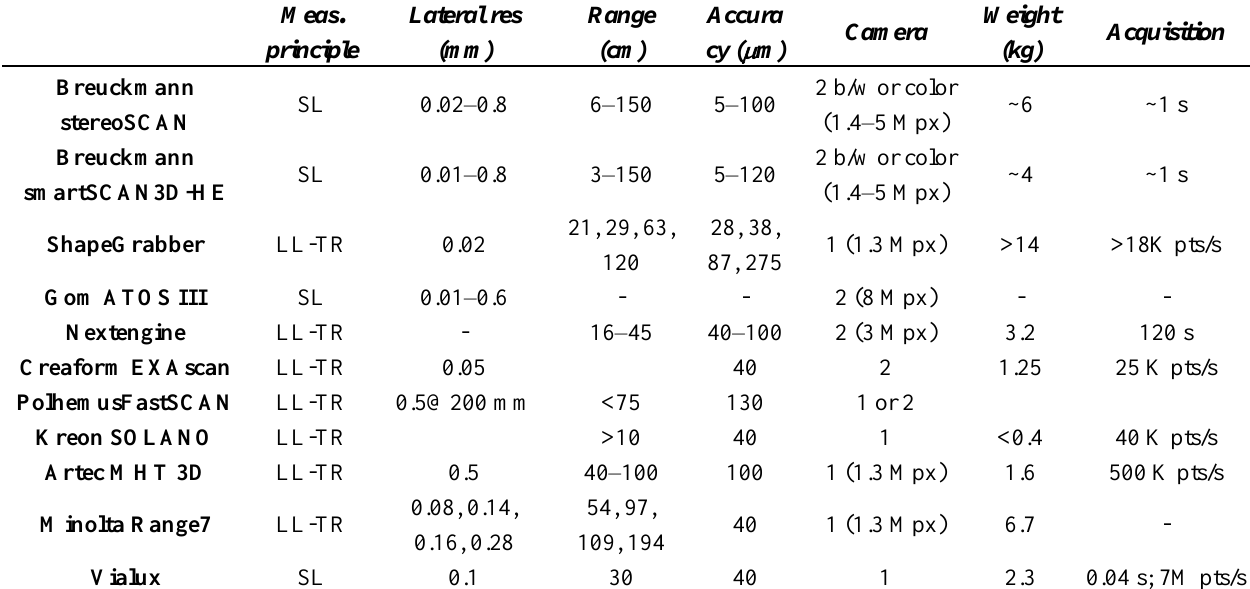
Table 2. Most common close-range terrestrial range sensors (LL = Laser light; TR = Triangulation-based systems; SL = Structured light